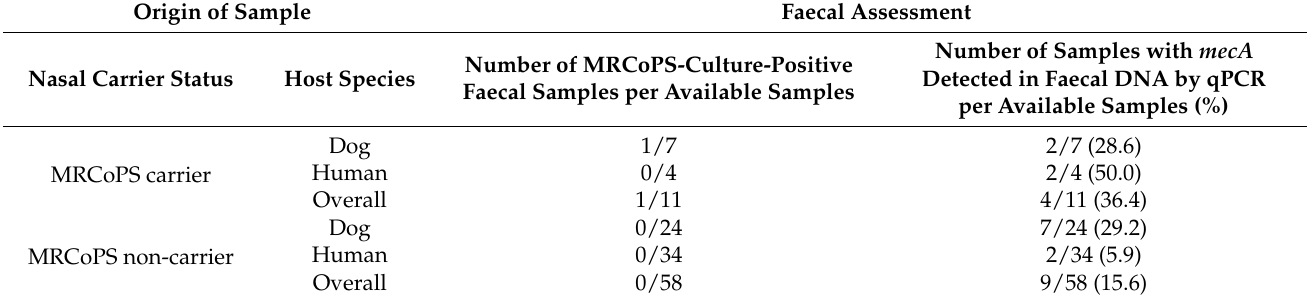
Table 1. Results from faecal assessment through culture and qPCR detection of mecA with respect to meticillin-resistant, coagulase-positive Staphylococcus species (MRCoPS) nasal carrier status of 31 canine and 38 human samples. Origin of Sample Faecal Assessment Number of Samples with mecA Number of MRCoPS-Culture-Positive Nasal Carrier Status Host Species Detected in Faecal DNA by qPCR Faecal Samples per Available Samples per Available Samples